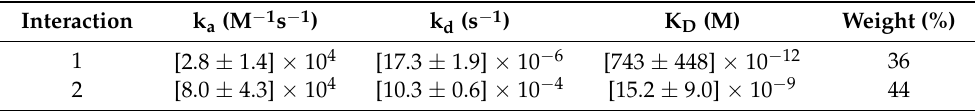
Table 2. InteractionMap evaluation of the affinity of 177 Lu labeled PEP40233 binding to HER2- expressing SKOV-3 cells in the presence of